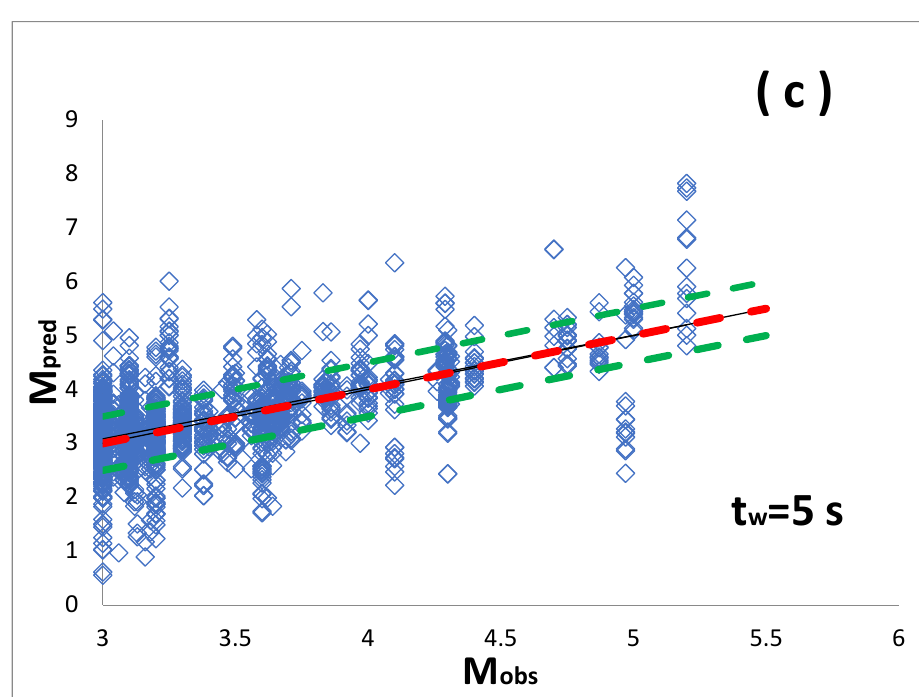
Figure 6. The predicted magnitude M pred along with that observed M obs for 3 s ( a ), 4 s ( b ), and 5 s ( c ) from the P arrival. The red line indicated the dichotomous while the two green lines are ±0.5 units from the dichotomous, respectively. Table 1. The average values of ration M pred /M obs and the deviation M pred -M obs for the t w used.